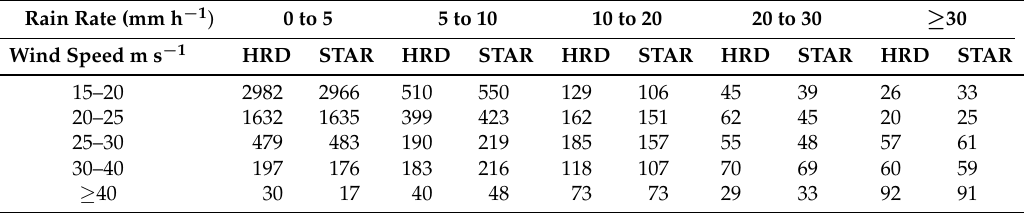
Table 8. Wind-Speed Retrieval Error Counts for the HRD and STAR